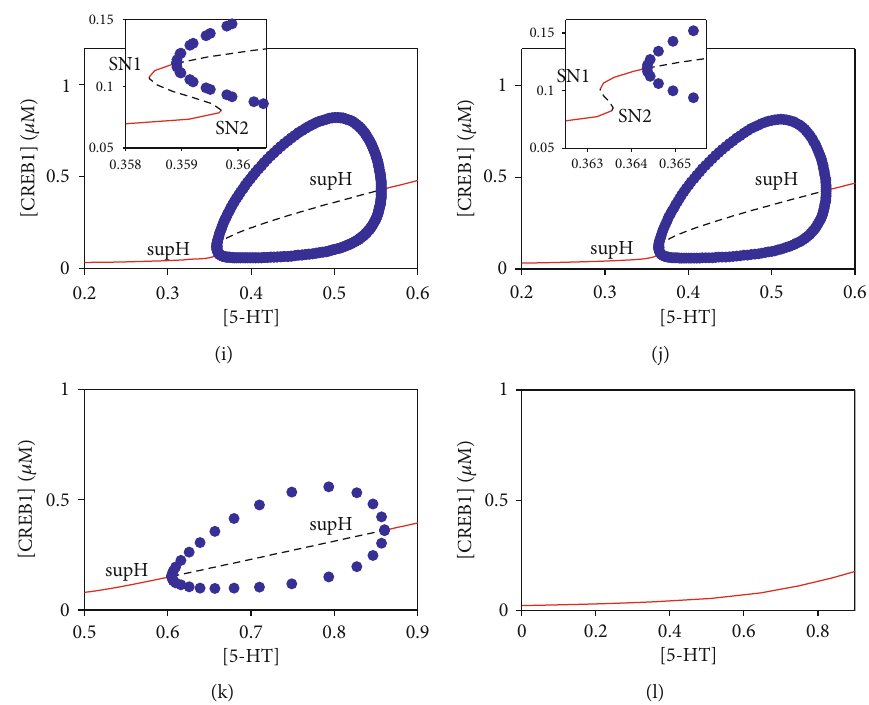
Figure 3: Bifurcation diagrams of [CREB1] versus [5-HT] at twelve values of V lines and black dashed lines, respectively. For the stable and unstable limit cycles, the maximum and minimum values of [CREB1] are denoted by blue solid circles and green open circles, respectively. (a – l) correspond to V respectively, as marked in Figure